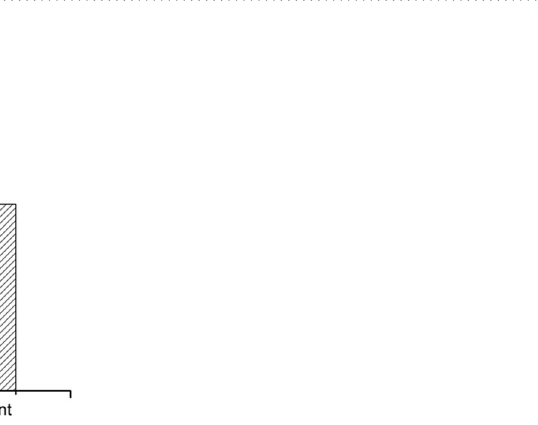
Figure 2. 3D micro-CT images of AgNO 3 that had infiltrated through the exposed dentin and along the post- dentin interface. ( A ) Resin cement with PBS. ( B ) Resin cement with TC. ( C ) RMGI with PBS. ( D ) RMGI with TC.